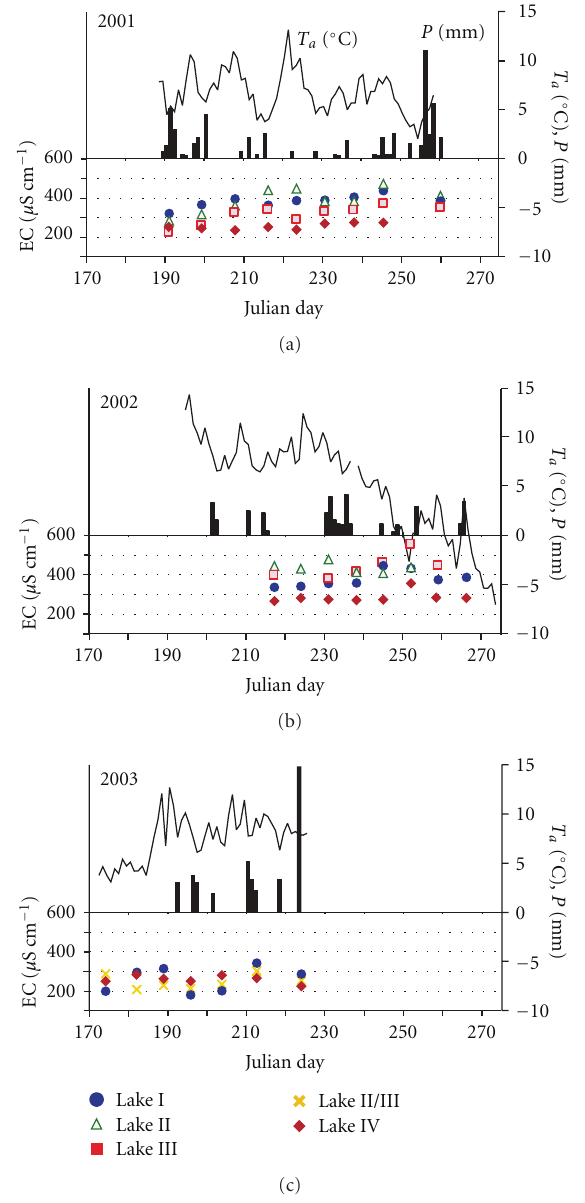
Figure 2: Mean daily air temperature T a and daily precipitation P at Skottehytta and specific electric conductivity EC in Lakes I–IV during summer 2001, 2002, and 2003; reference period from June 19 (170 Julian day) to October